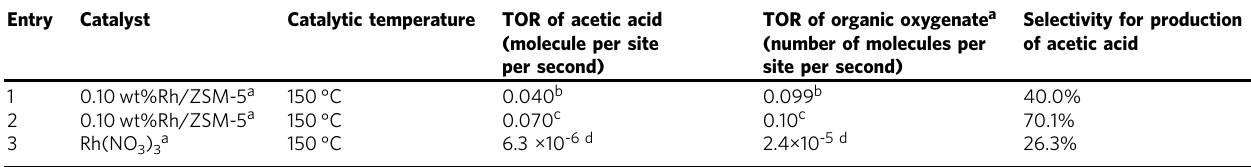
Table 1 Comparison of TOR for formation of acetic acid or oxygenates including acetic acid, formic acid and methanol on 0.10 wt %Rh/ZSM-5